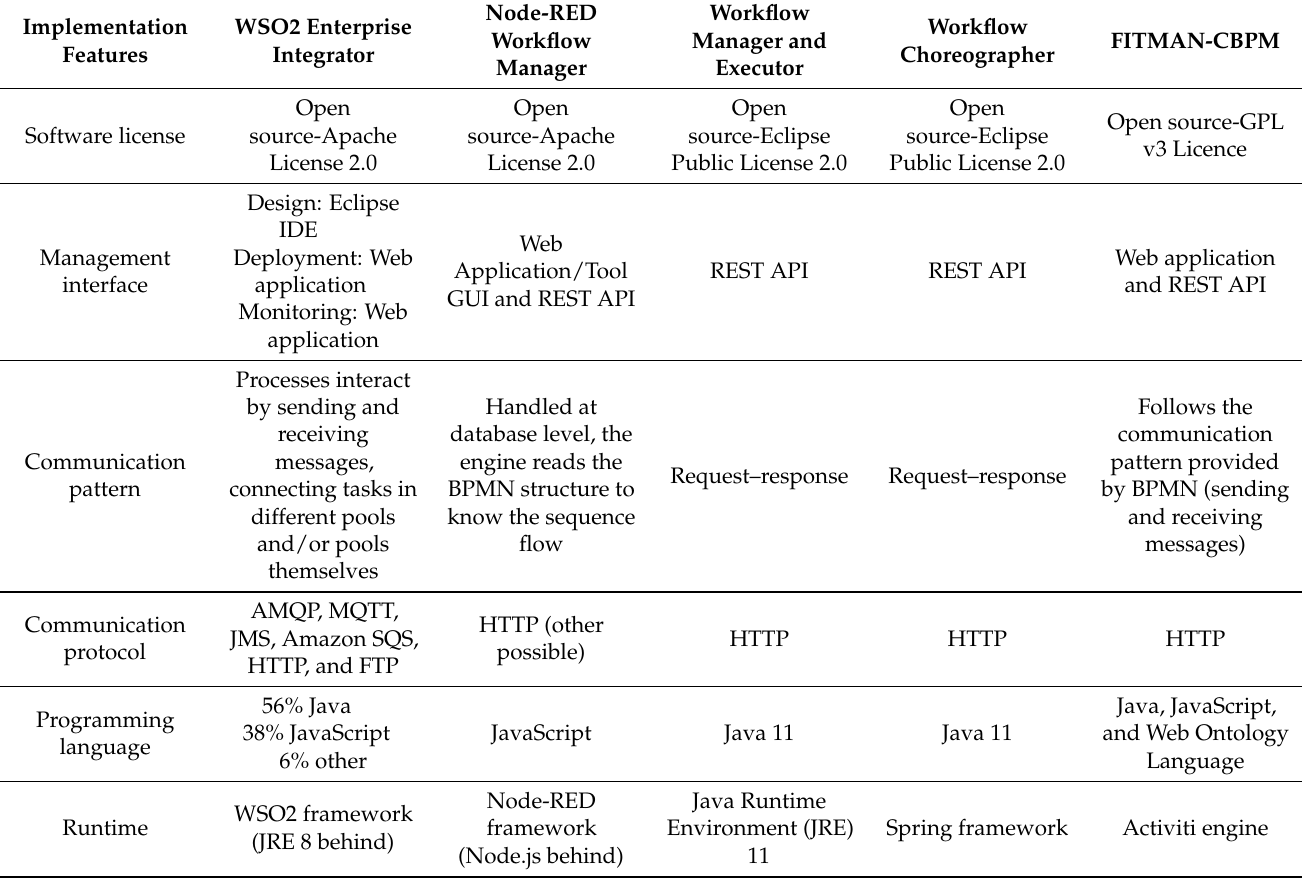
Table 2. Implementation features of the open source workflow technologies